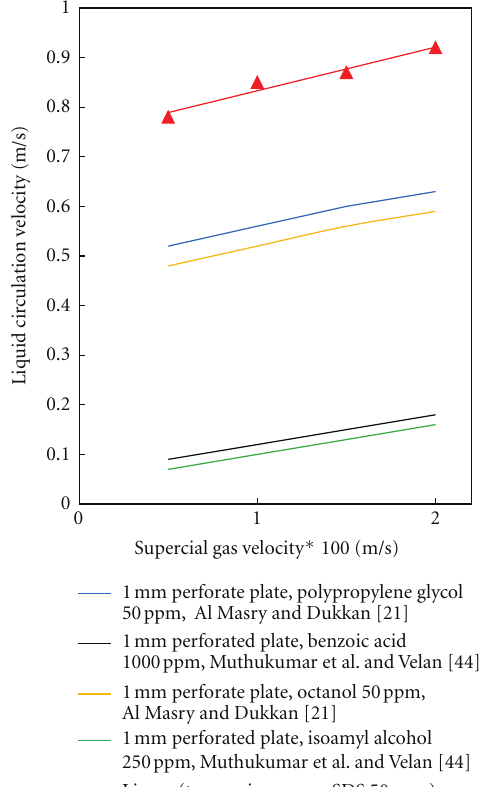
Figure 17: E ff ect of contaminants on liquid circulation velocity in ALR ( C S = 50ppm, Δ P S =